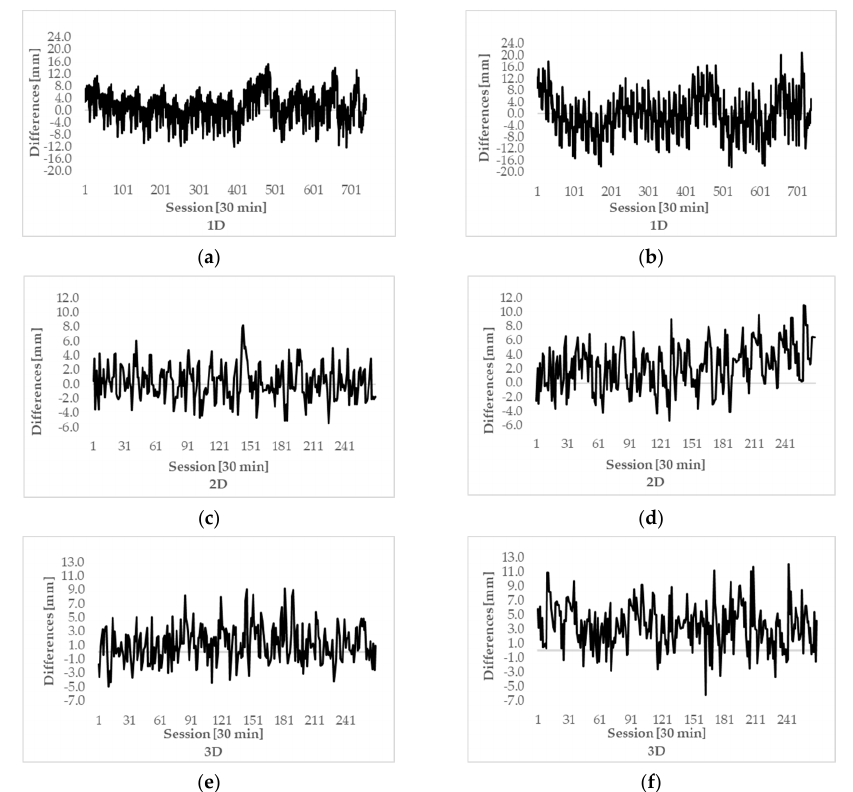
Figure 7. 1D, 2D and 3D differences between true and estimated displacement of point FGG1: ( a ) 1D, G-baseline; ( b ) 1D, L-baseline; ( c ) 2D, G-baseline; ( d ) 2D, L-baseline; ( e ) 3D, G-baseline; ( f ) 3D, L-baseline.